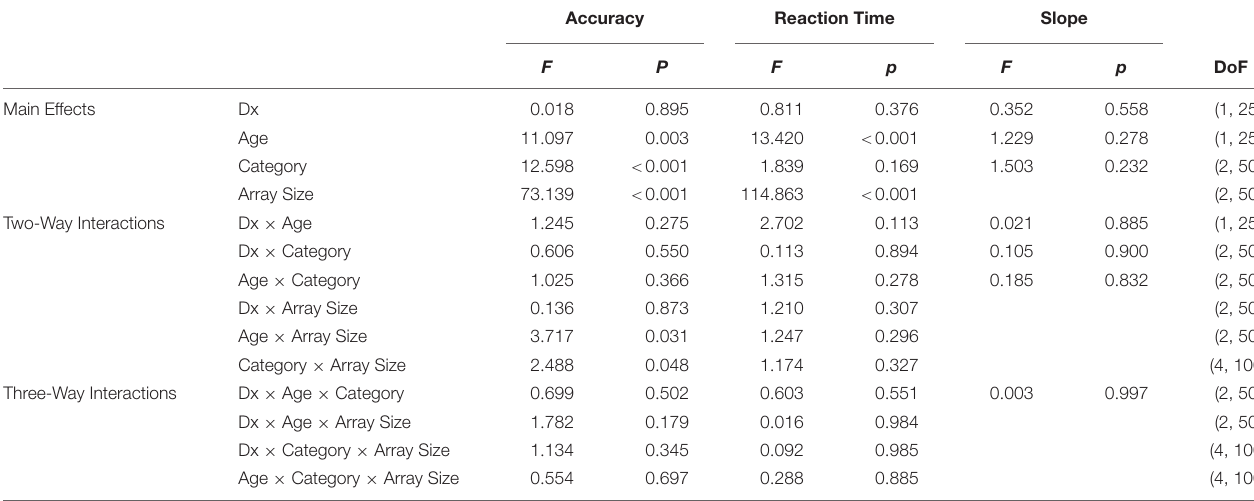
TABLE 3A | Exemplar task